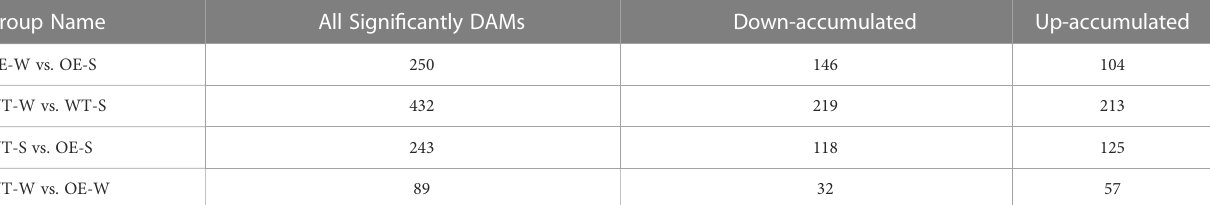
TABLE 1 Signi fi cant DAMs in different